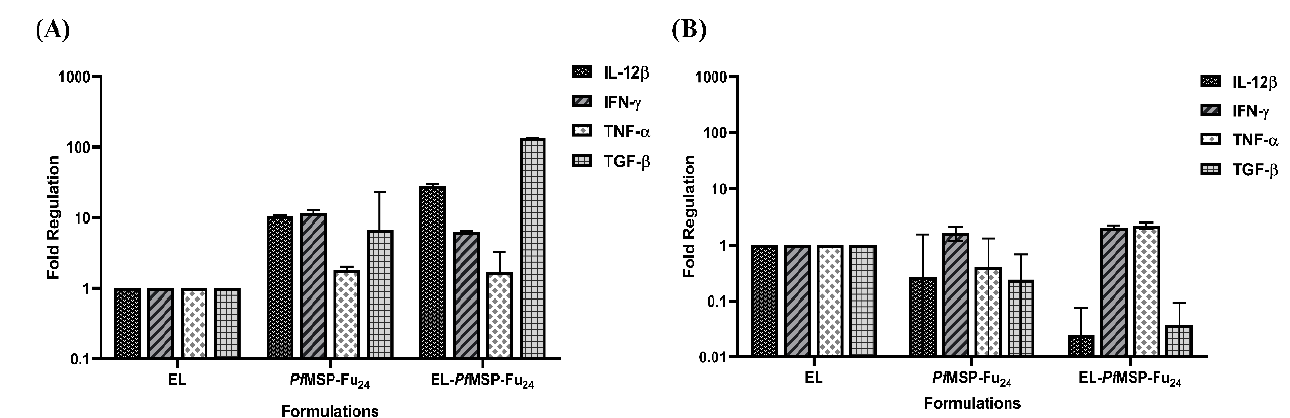
Figure 4. The transcript expression analysis of ( A )IL-10 and ( B ) IFN-γ by RT-PCR in the spleen of BALB/c mice vaccinated with plain ( Pf MSP-Fu 24 ) and Pf MSP-Fu 24 -laden elastic liposomes (EL-PfMSP-Fu 24 ).